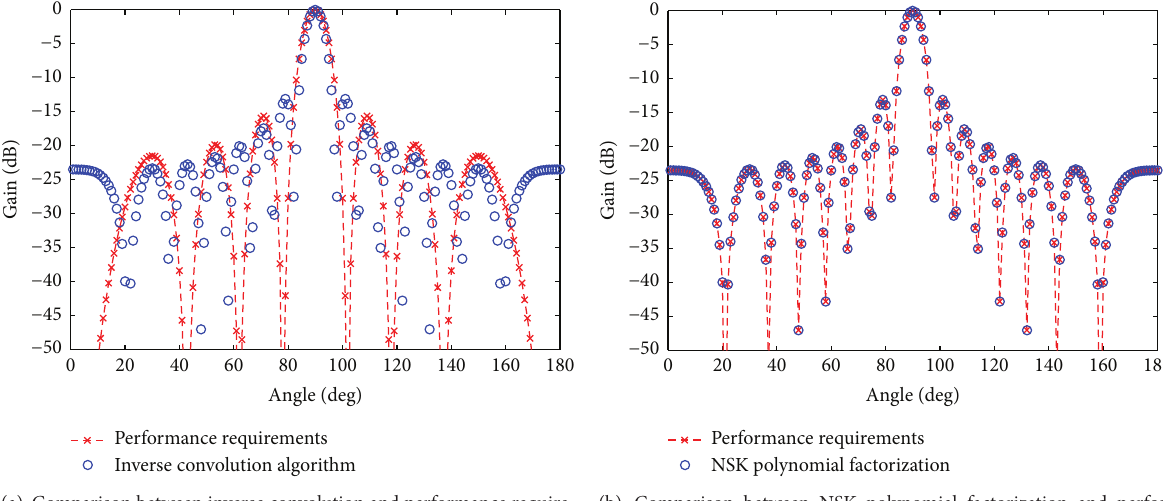
(b) Comparison between NSK polynomial factorization and perfor- mance requirements Figure 6: Performance of different